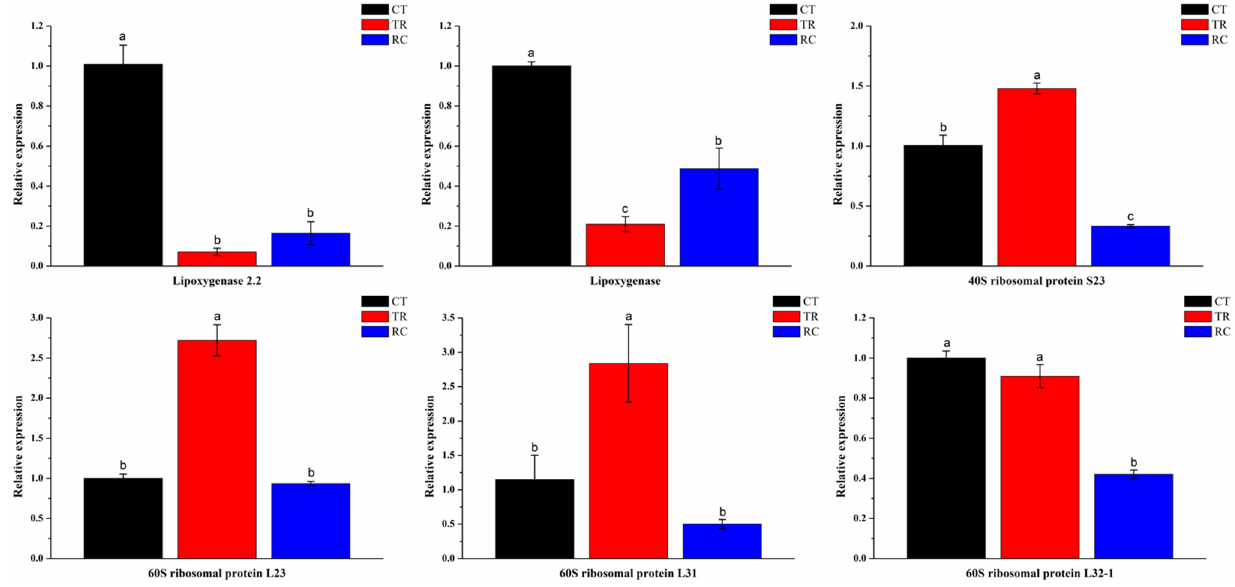
Figure 9. The qRT-PCR analysis shows the genes expression of Lipoxygenase 2.2, Lipoxygenase, 40S ribosomal protein S23, 60S ribosomal protein L23, 60S ribosomal protein L31 and 60S ribosomal protein L32-1 under three different temperature treatments. Columns with different letters are significant difference (LSD test, p < 0.01). Error bars are the standard error ( ± SE) of three biological replications. CT: Normal-temperature treatment. TR: Chilling treatment. RC: Recovery to normal- temperature